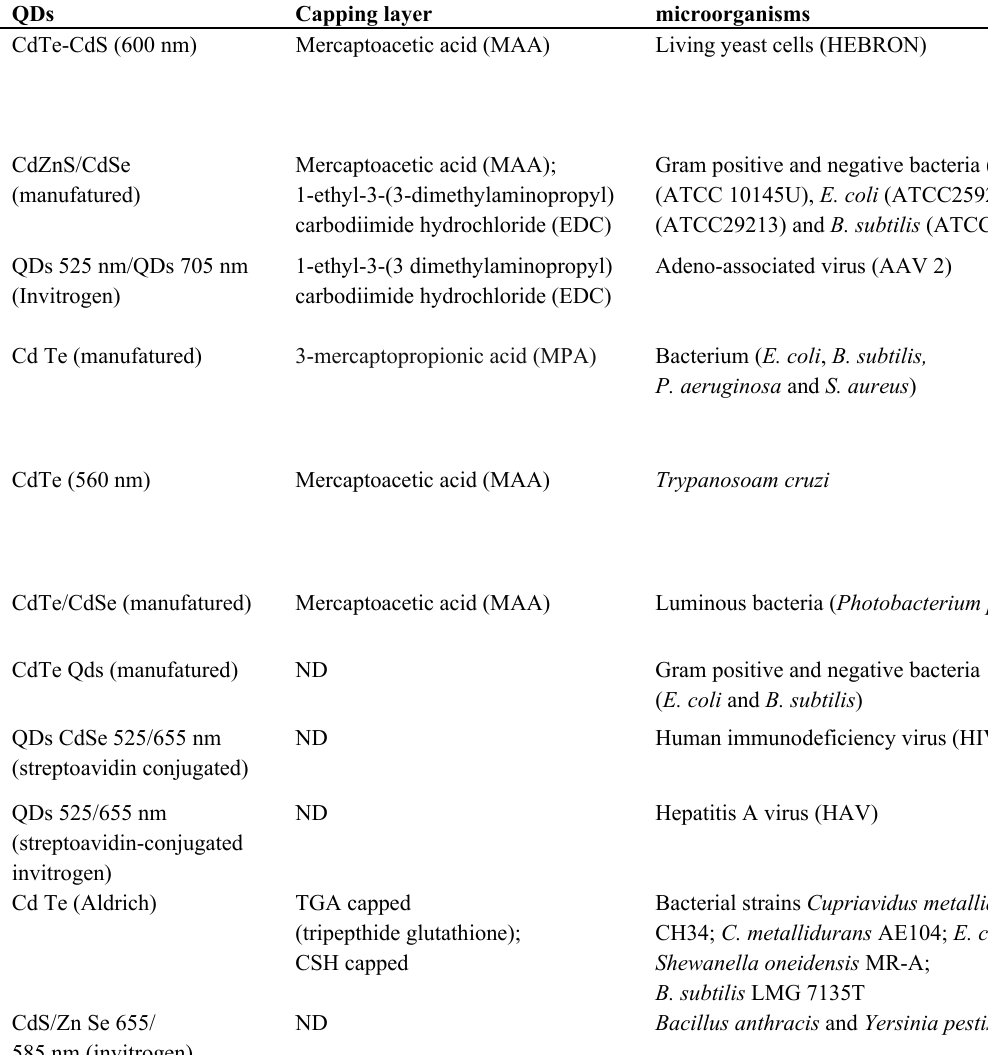
Table 1. QDs on different microorganisms (ND—Not